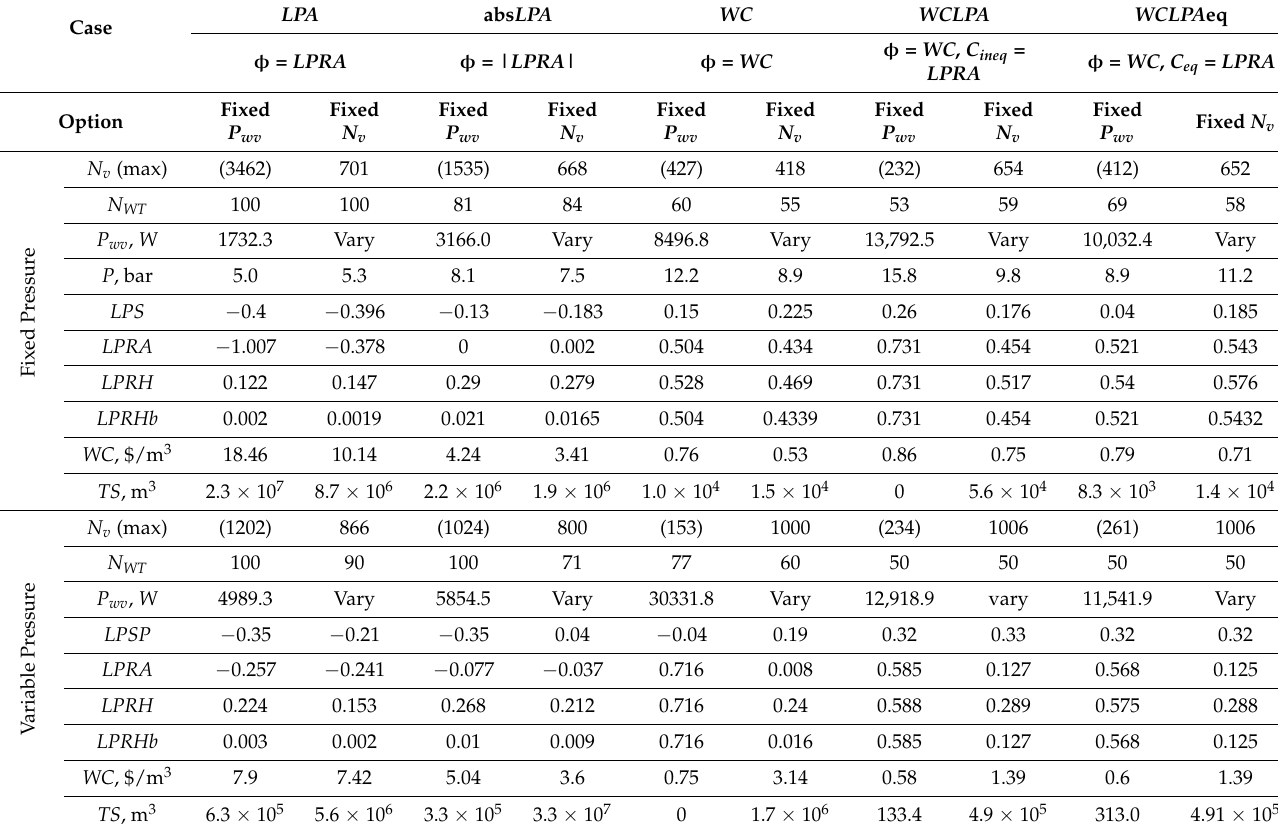
Table 2. Optimization results for satisfying the yearly